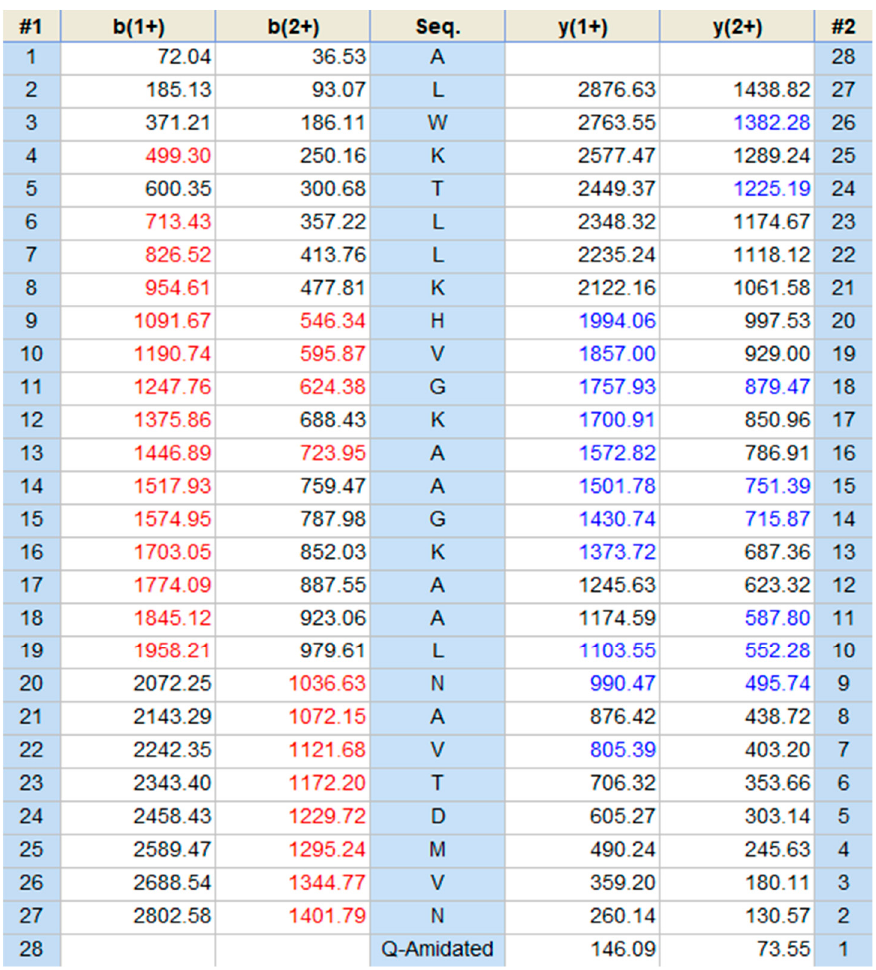
Figure 3. Electrospray ion-trap MS/MS fragmentation data derived from fragment ions corresponding to molecular mass to Der-PS4. Predicted singly and doubly charged b -ions and y -ions are in black typeface. Ions detected by MS/MS fragmentation are indicated in red and blue.